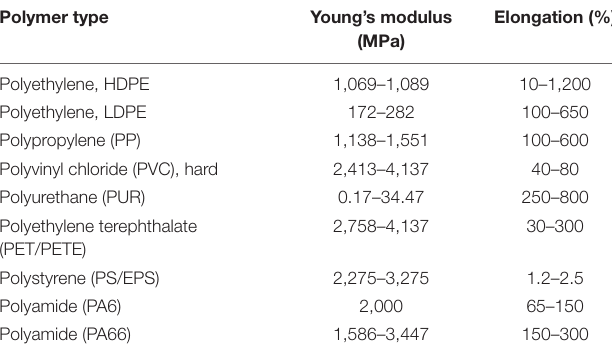
TABLE 3 | Young’s modulus of elasticity and elongation for selected polymer types (Harper and Petrie, 2003). Polymer